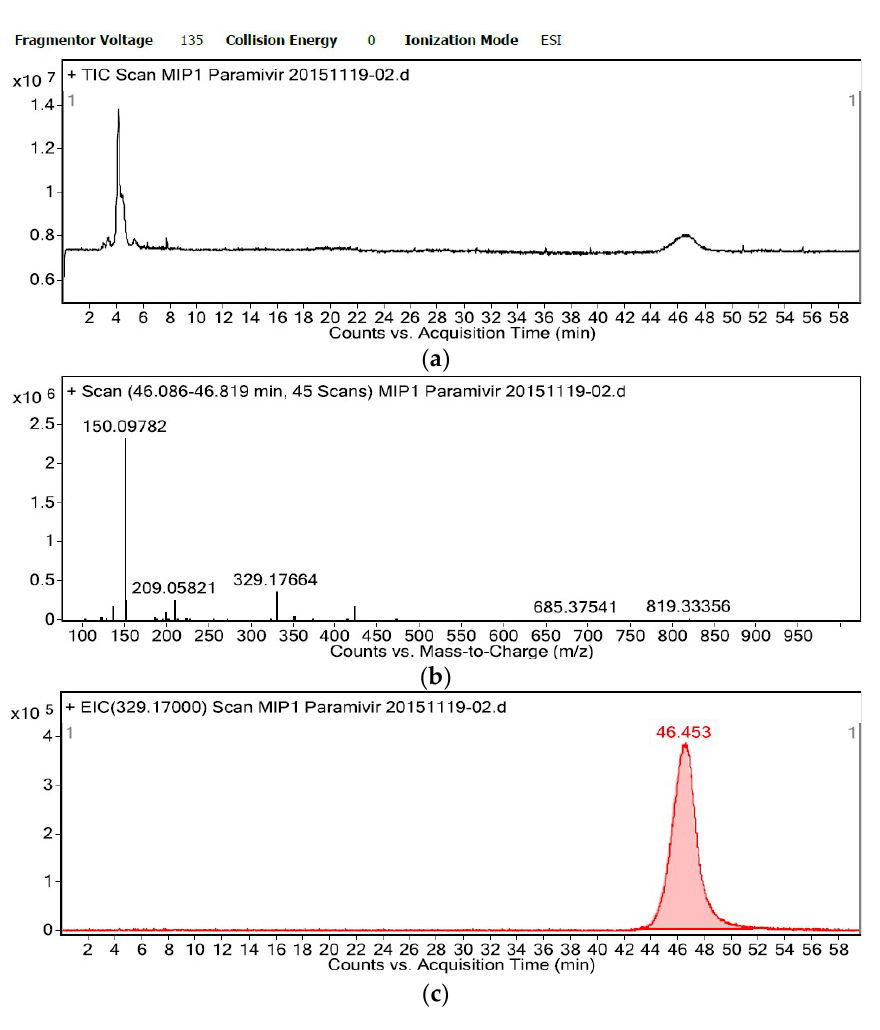
Figure 6. Spectra of peramivir standard solution on the OSMIP@silica gel column ( a ) TIC, ( b ) MS spectrum from 46 to 47 min, ( c ) EIC of m / z 329.17).